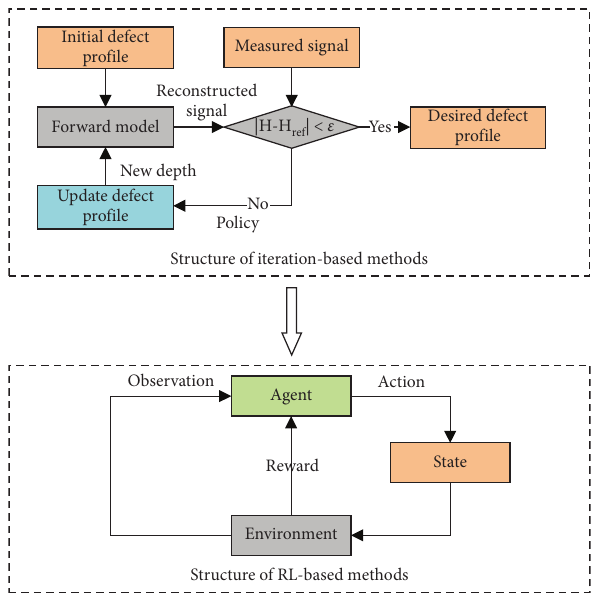
Figure 4: Similarity between the learning process of reinforcement learning and classic iteration